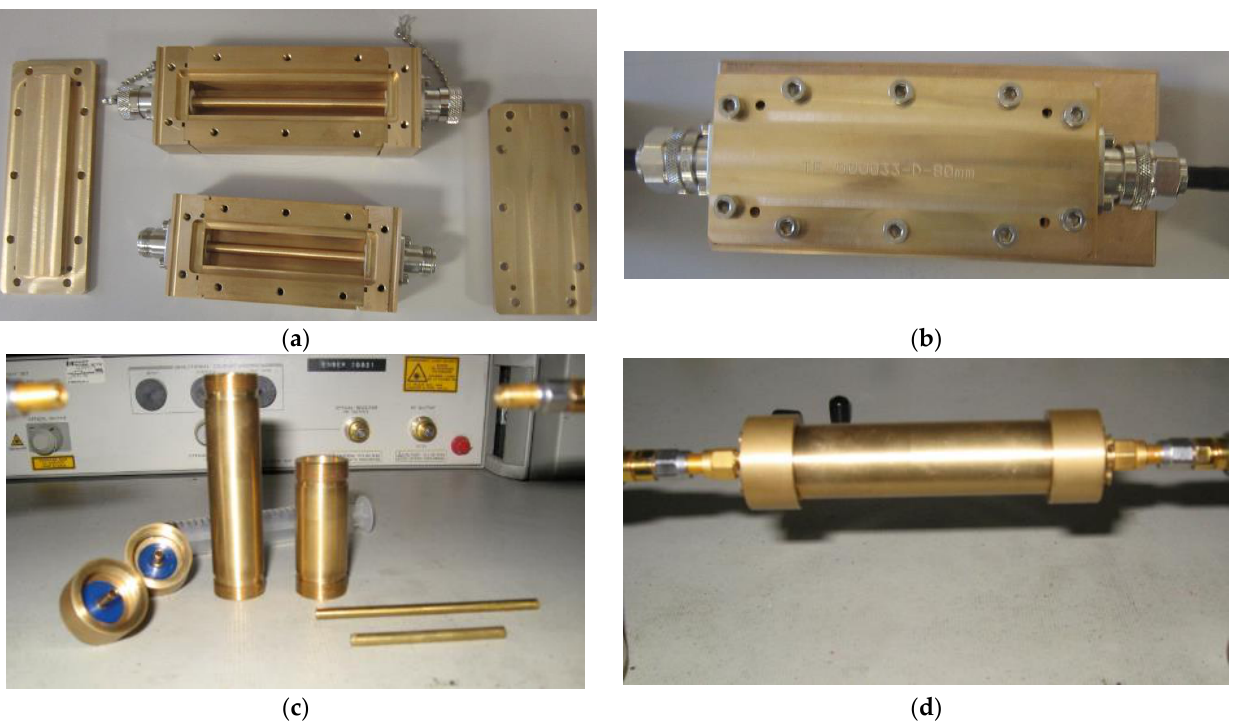
Figure 3. ( a ) Top view of the rectangular coaxial test cell; ( b ) the rectangular coaxial fixture linked to the VNA access port; ( c ) side view of the circular coaxial fixture elements; ( d ) the circular coaxial fixture linked to the VNA access port. The experimental results are depicted in Figures 4 – 10 for the six MUTs.